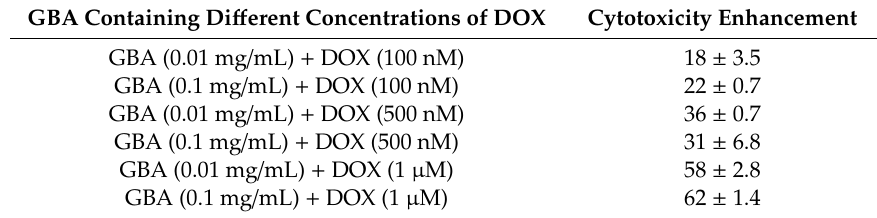
Table 6. Cytotoxicity enhancement of DOX-loaded GBA in MCF-7 cells (25.000 / well).